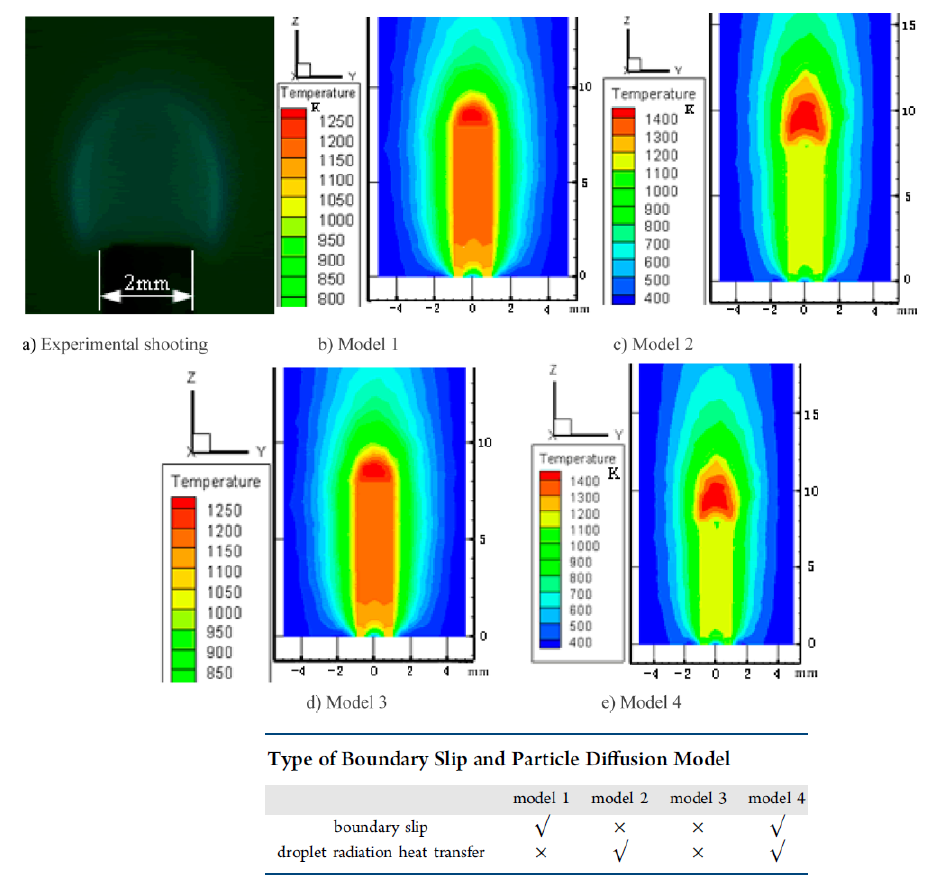
Figure 8. Experimental and numerical study of a liquid ethanol micro-combustion in ceramic tubes with different inner diameters by Xu et al. [18]. Flame characteristics for tube 1 at flow rate of 1.8